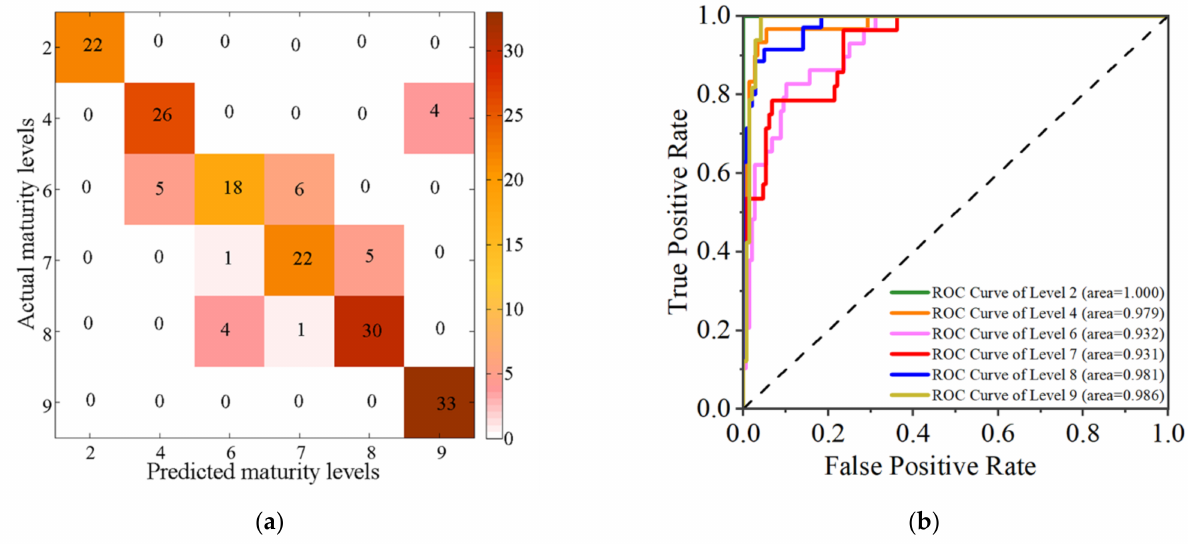
Figure 5. Performance of the interval PLSDA model represented by ( a ) confusion matrix; and ( b ) ROC